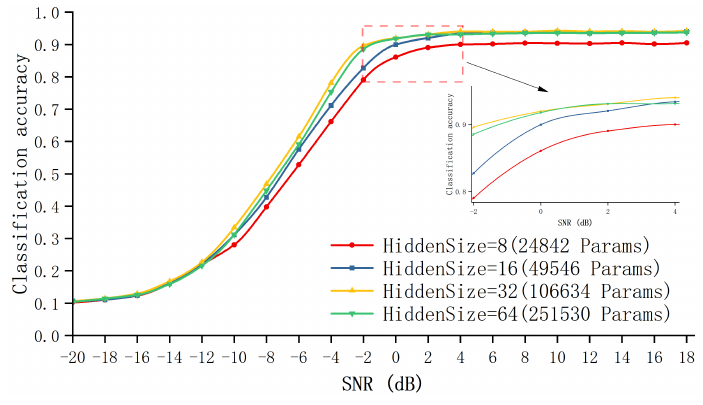
Figure 16. Classification accuracy vs. SNRs for TMRN-GLU with different Encoder hidden size.